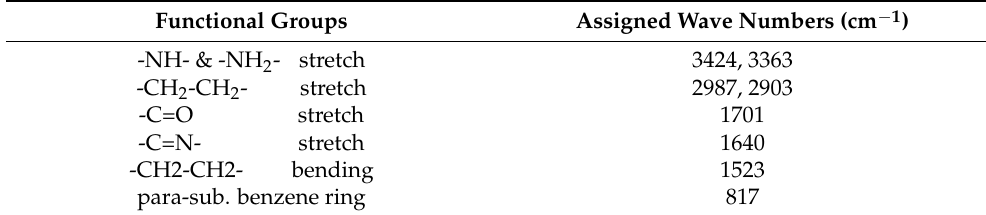
Figure 1 . FTIR-spectra of DETA, TPAl, and co-polyimine. Figure 1. FTIR-spectra of DETA, TPAl, and co-polyimine. Table 1. Assignments of main functional groups of DETA, TPAl, and Table 1. Assignments of main functional groups of DETA, TPAl, and Co-PIM.